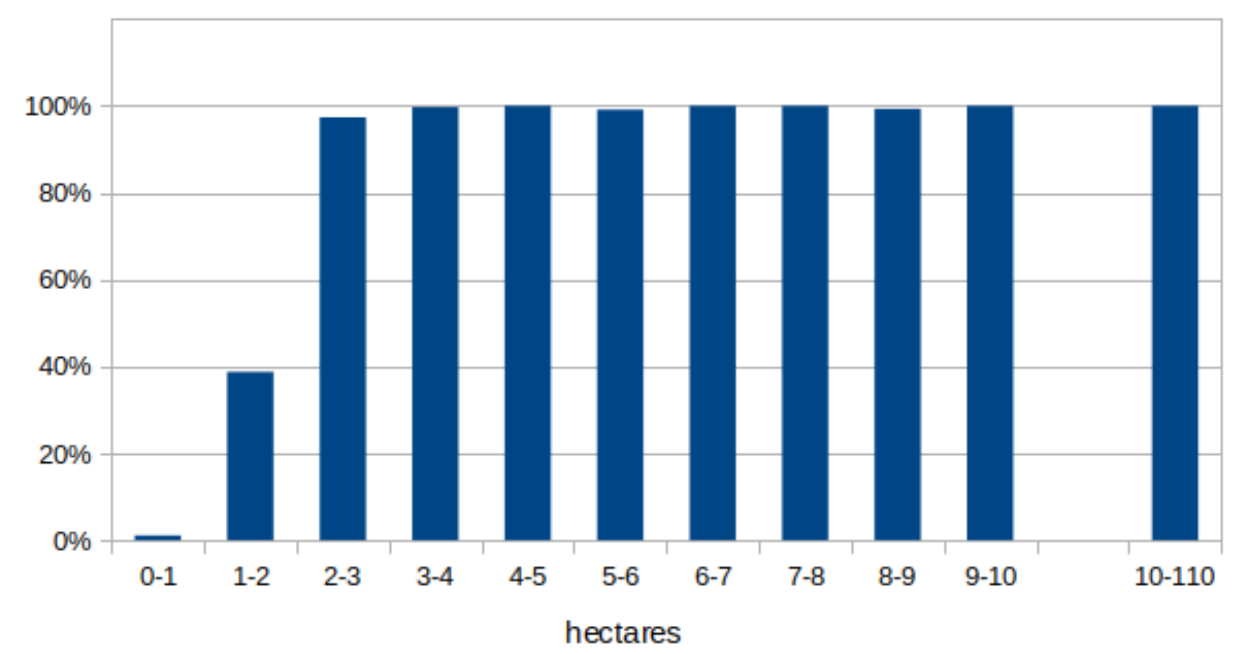
Figure 4. Incidence of farms that obtained the certification, according to their size.